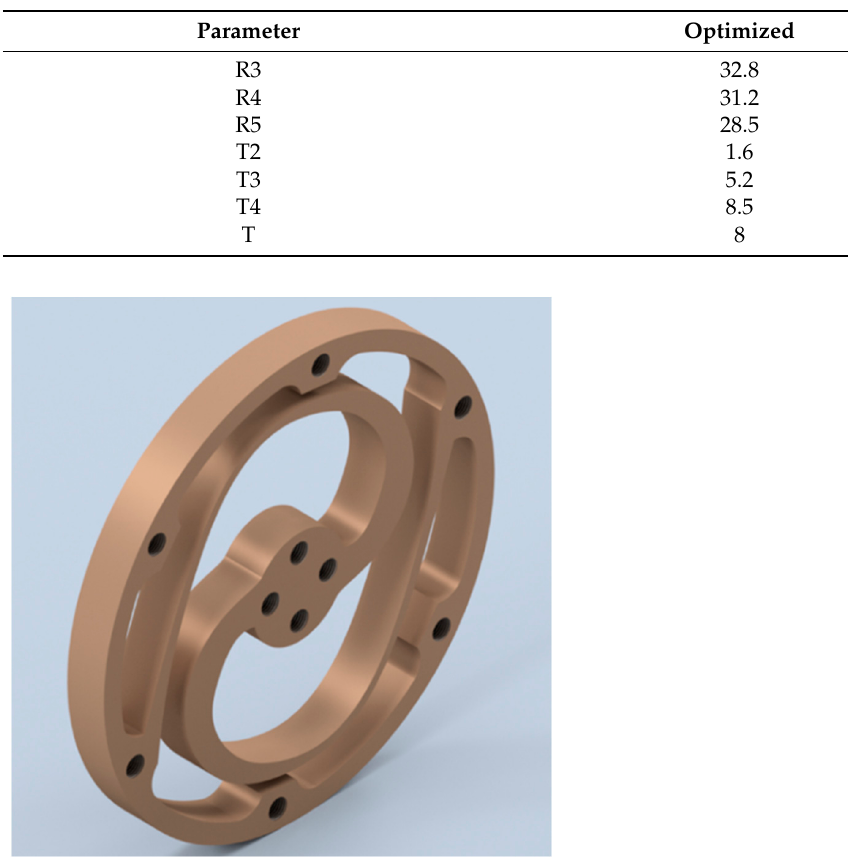
( b ) Figure 9. FEM results: ( a ) Module deformation (mm); ( b ) Von Mises stress (MPa). 4. Experimental Characterization of Torsion Spring 4.1. Manufacturing of the Torsion Spring The torsion spring model was optimized using the FEM design technique, as shown in Figure 10. In the early stages of spring design, design for manufacturing (DFM) consid- erations were taken into account to provide feedback on the spring design and avoid any challenges during the final prototype manufacturing. With DFM, potential issues can be addressed early in the design stage, saving time and money. As a result, the decision to select the appropriate cutting machine for the manufacturing process was made based on DFM considerations and recommendations.